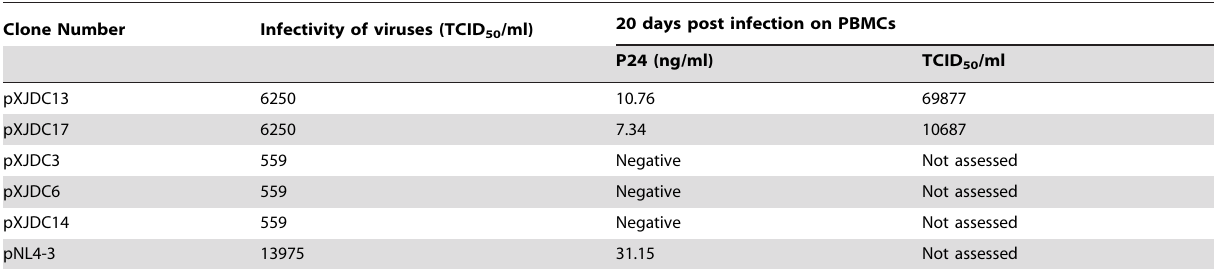
Table 3. Infectivity and replication capability of repaired